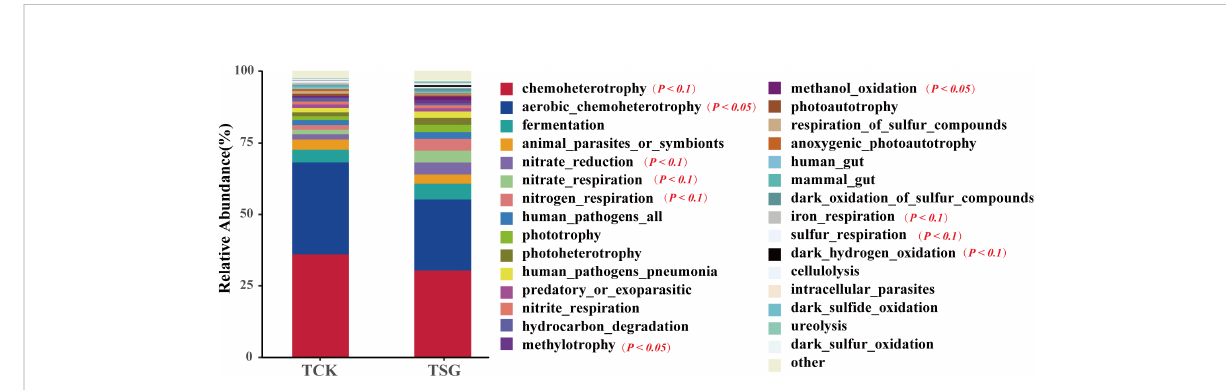
FIGURE 6 Relative abundance histogram of TOP-30 bacterial community function prediction based on FAPROTAX for two groups of